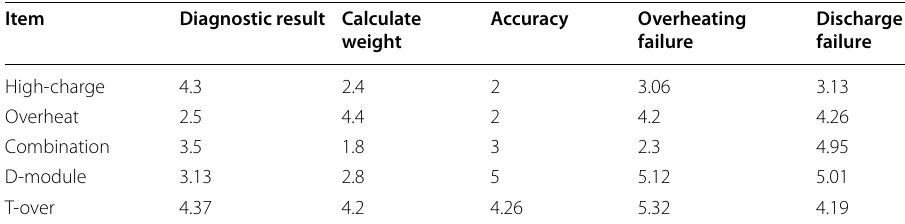
Table 14 Fault type score data table